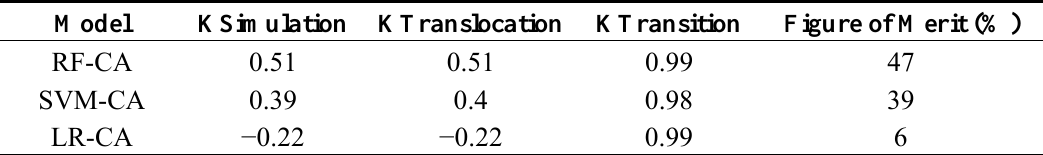
Table 4. Validation statistics for all simulation